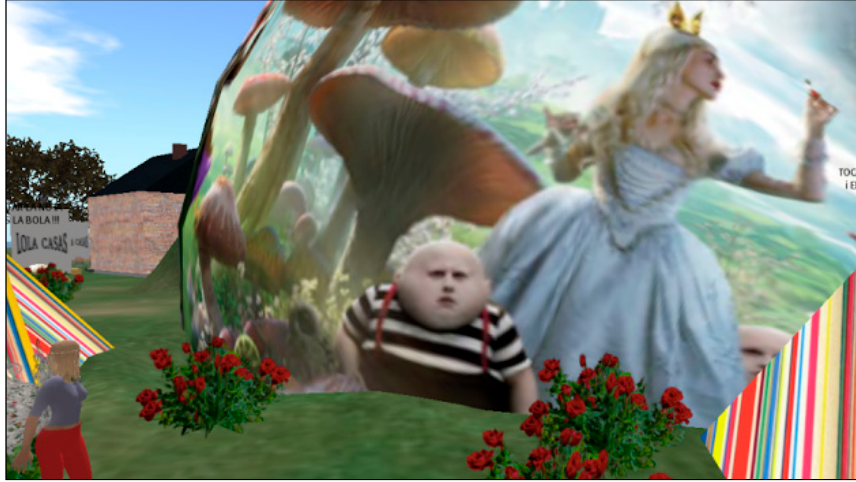
Figure 1. An example of virtual